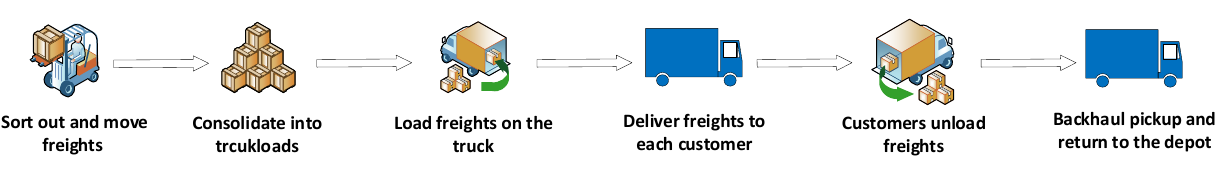
Figure 3. Freight delivery operations modelled by DES.